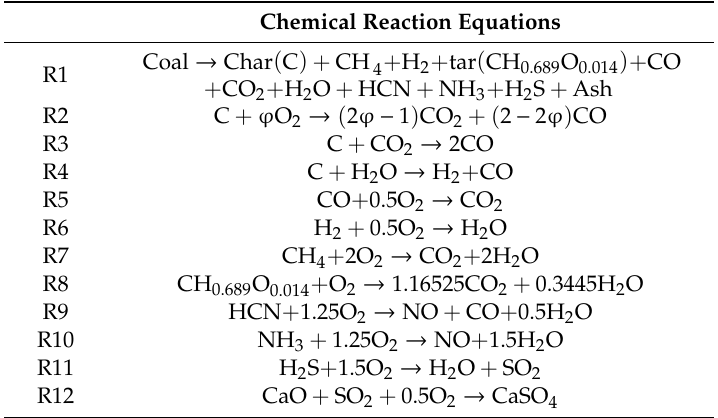
Table 3. Chemical reaction equation.